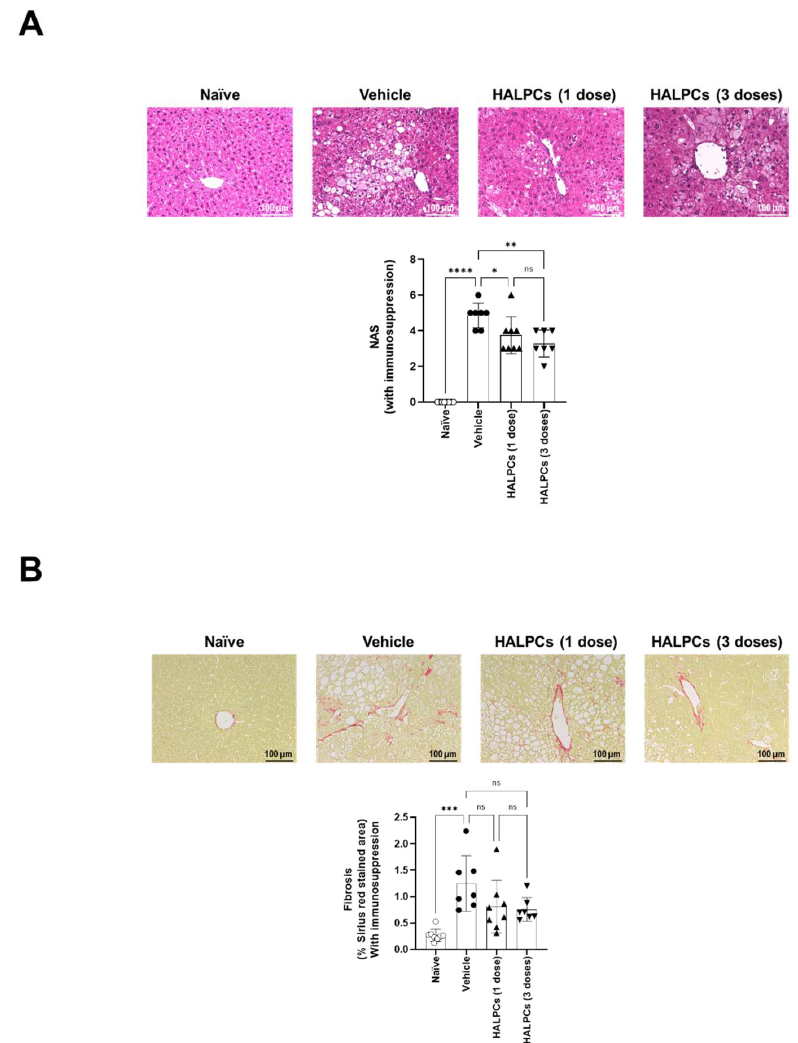
Figure 6. Evaluation of HALPC transplantation efficacy in late-stage NASH mouse model under immunosuppression regimen. ( A ) Representative photomicrographs of HE-stained liver sections. NAFLD Activity Score (NAS) was calculated according to the criteria of Kleiner [30]. ( B ) Representative photomicrograph of Sirius red-stained sections. Bright field images were captured around the central vein using a digital camera (DFC295; Leica, Germany) at 200-fold magnification, and the positive areas in 5 fields/section were measured using ImageJ Software (National Institute of Health, USA). ns: not significant; *: p < 0.05; **: p < 0.01; ***: p < 0.001; ****: p < 0.0001 (Tukey Multiple Comparison Test).